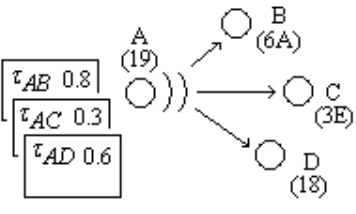
Figure 3. ACO parameters memorized in the